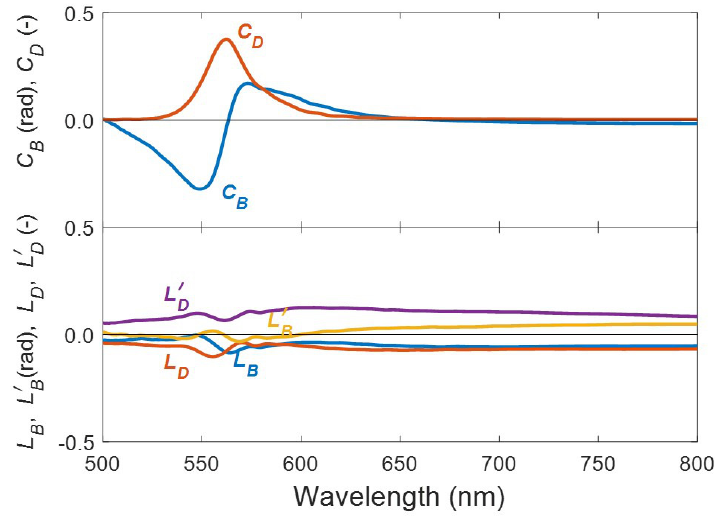
Figure 8. Birefringence and dichroism of the elytron from C. aurata (sample CA2).